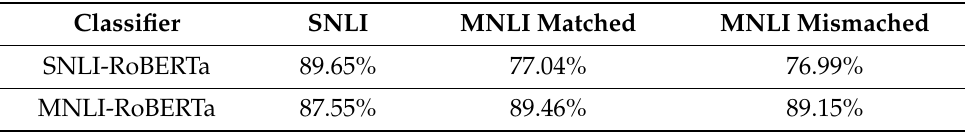
Table 7. Accuracy Comparison of Two